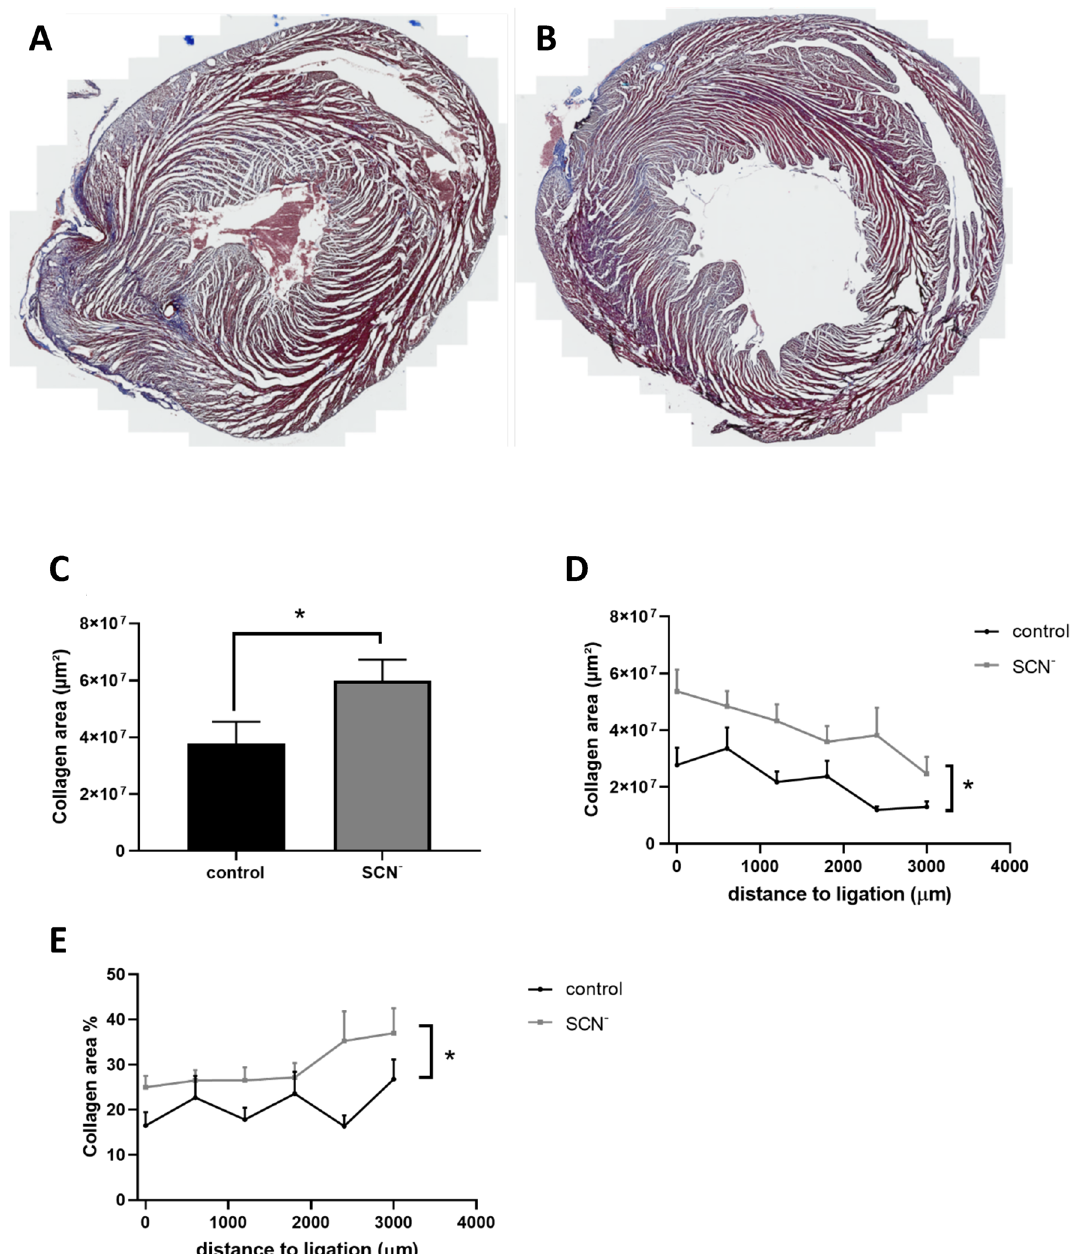
Figure 5. Supplementation with SCN − increases content of collagen. Panels ( A ) and ( B ) show representative Trichrome-stained images taken at the site of ligation at 24 h post surgery from: ( A ) a vehicle/IR rat, and ( B ) a SCN – supplemented/IR rat, with the blue staining depicting collagen. ( C ) shows the quantification of collagen areas from 6 sections taken between the ligation site and apex in each heart from the control (black bar, n = 7 rats) and SCN – supplemented (grey bar, n = 6 rats) groups with * showing a significant (p < 0.05) difference between groups using a one-tailed t-test. ( D ) and ( E ) Quantification of collagen area was performed on individual sections taken from the site of ligation to the apex for control (black line) and SCN − (grey line) groups with data in (E) expressed as percentage of the total stained area in the section. Data represent mean ± SEM of n ≥ 6 rats with * showing a significant difference between the vehicle/IR animals and the SCN − -supplemented/IR group, using 2-way ANOVA with a Sidak post-hoc